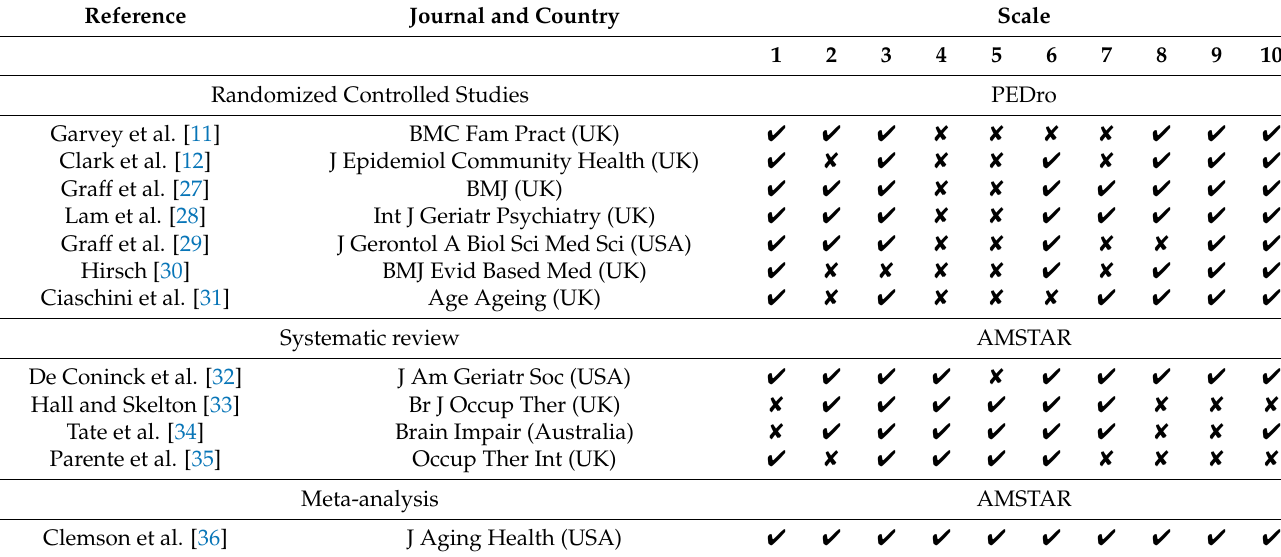
Table 1. Methodological